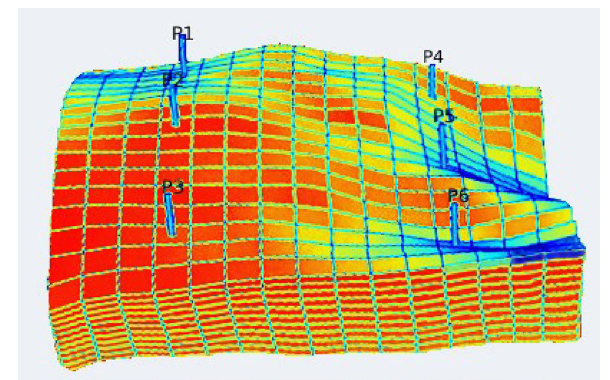
Fig. 1 Schematic of the simulated sector